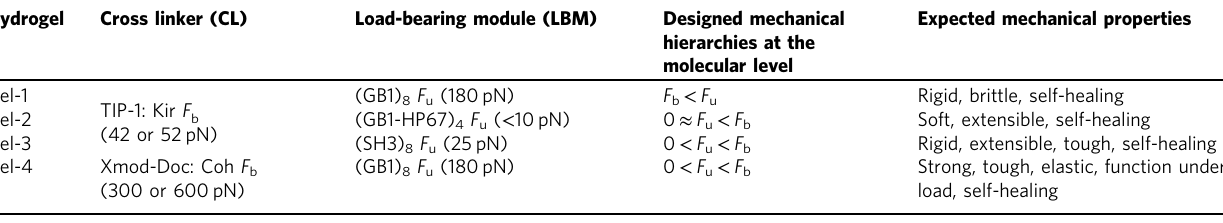
F b break force of the CL, F u unfolding force of the LBM a The forces in the brackets were measured at a pulling speed of 400nms − 1